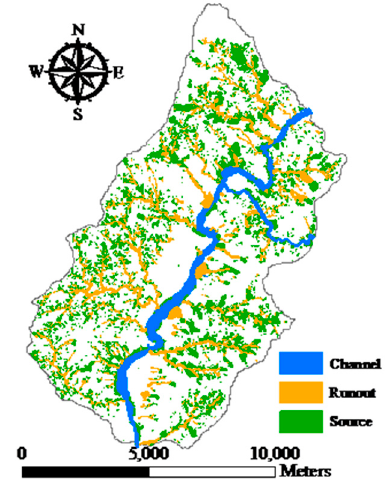
Figure 3. Landslide inventory. Table 1. Landslide inventory information.